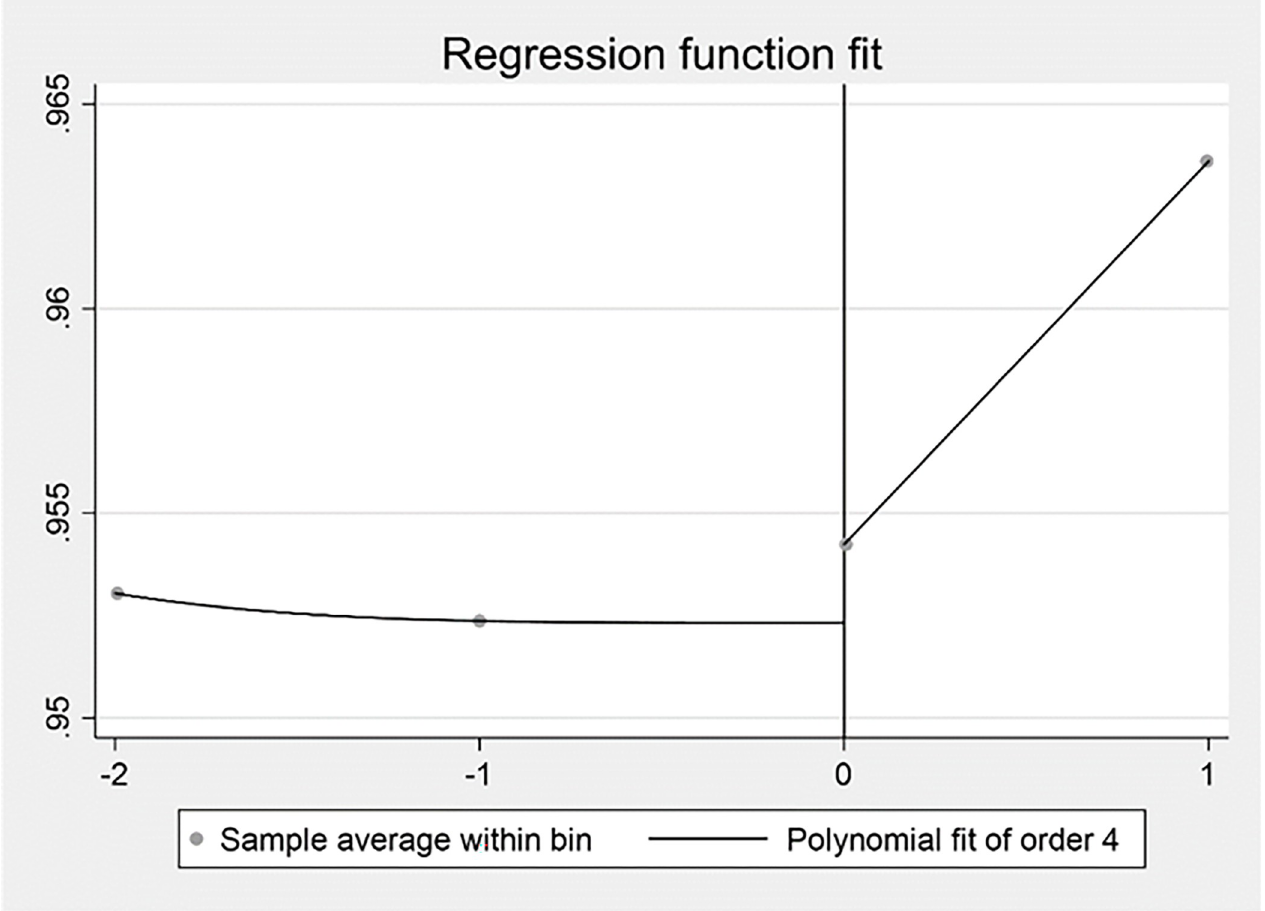
Fig 7. The COVID-19 pandemic and